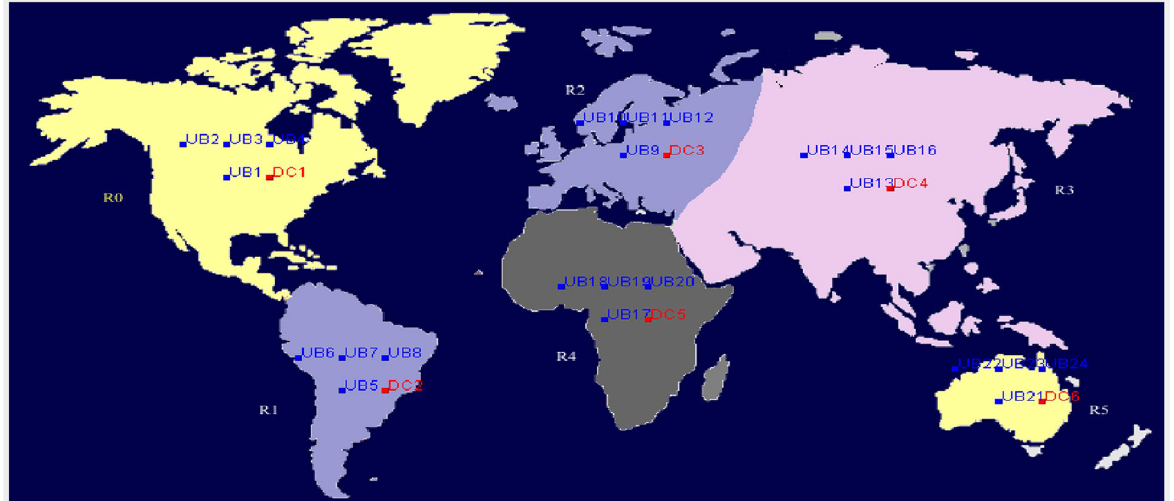
Fig. 7 Design of scenario 3 (4 UB 1 DC in each